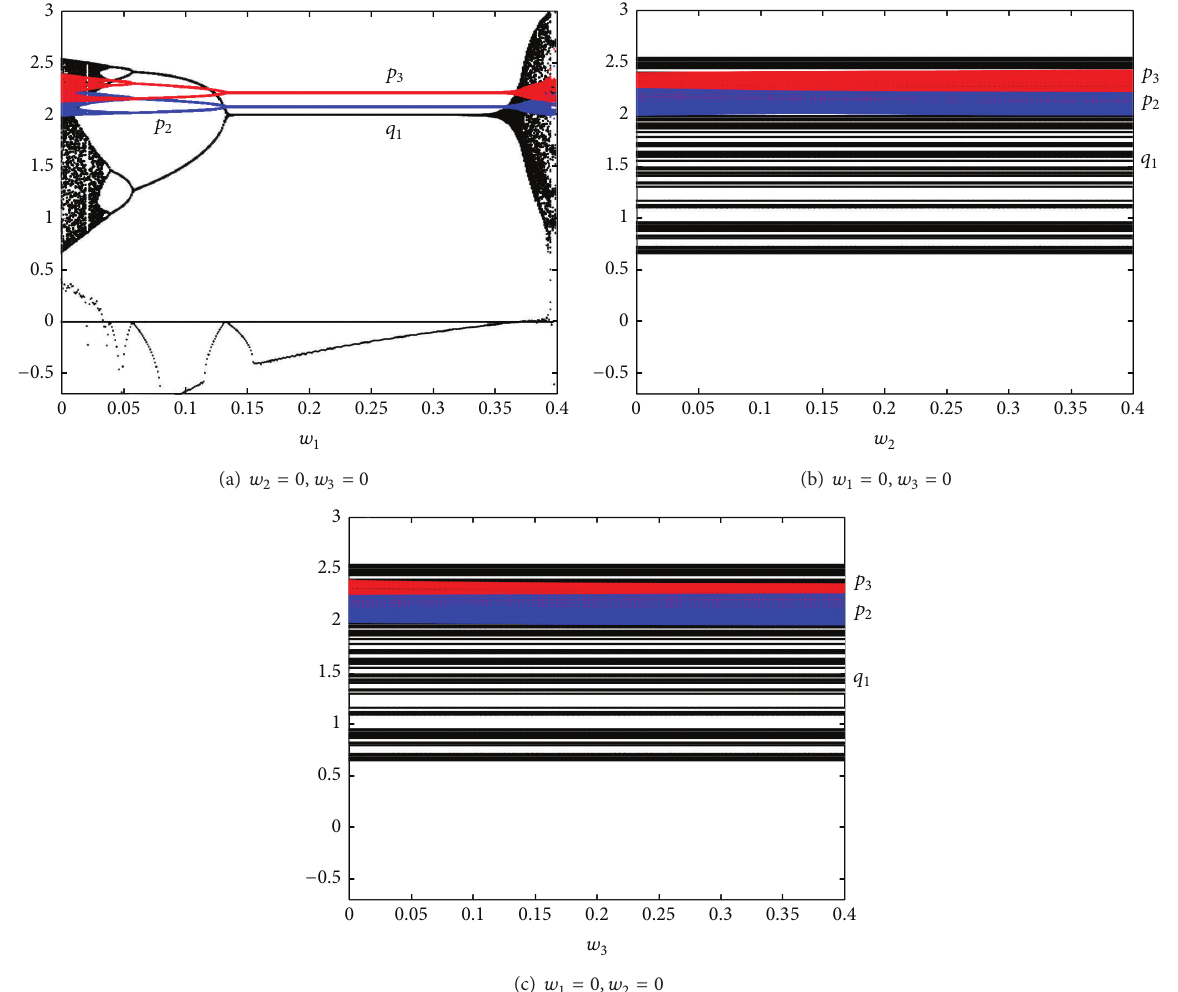
Figure 14: The bifurcation diagram and the corresponding largest Lyapunov exponent of the delayed system (25).